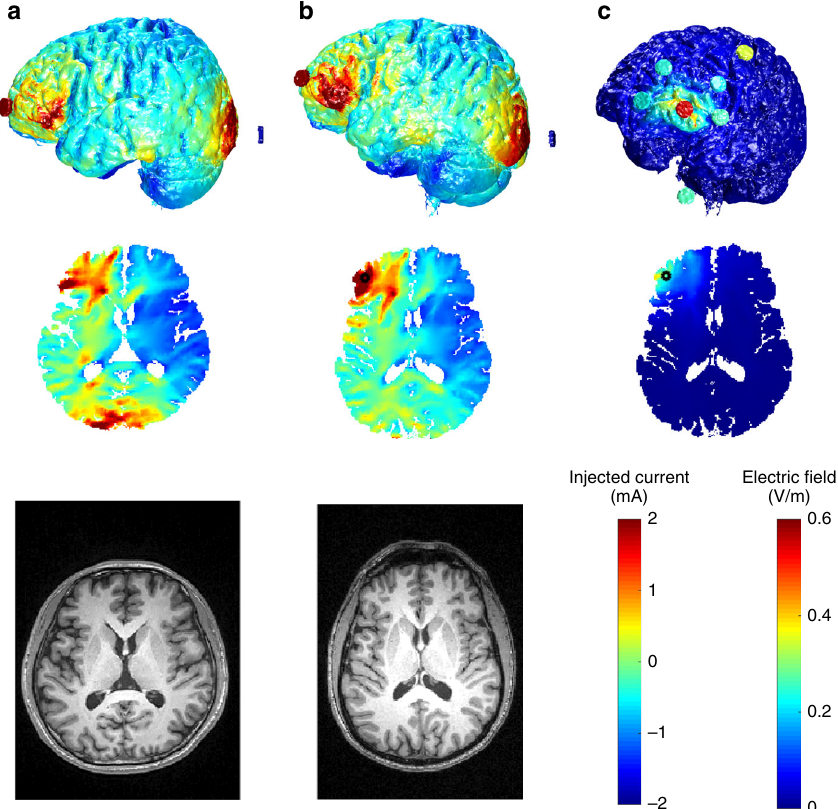
Fig. 5 Individualized models of transcranial electrical stimulation for two subjects with variable electrode placements. a Model of Subject 1, with 2 mA current injected at electrode Fp1 and return from electrode P3. b Model of Subject 2 with the same electrode con fi guration. c Model of Subject 2 with another electrode con fi guration attempting to achieve more focal stimulation. Note that stimulation is more focal but achieves weaker fi elds compared to b , due to increased current shunting through the skin between near-by electrodes. Electrode montages in b and c are obtained by a numerical optimization algorithm that attempts to achieve maximal intensity ( b ) or maximal focality ( c ) for the location indicated by a black circle. The current- fl ow models were generated from previously published data 118 and methods 119 . We used ROAST, a toolbox for realistic current- fl ow models of the human